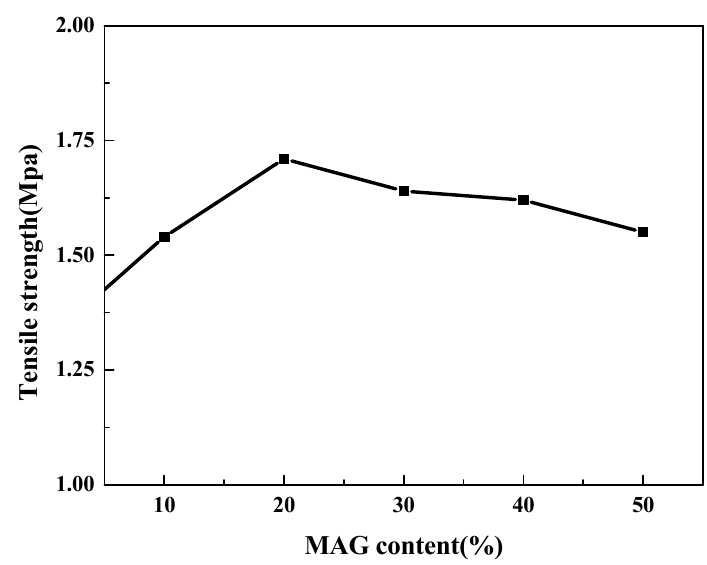
Figure 5. Mechanical properties of composite films.